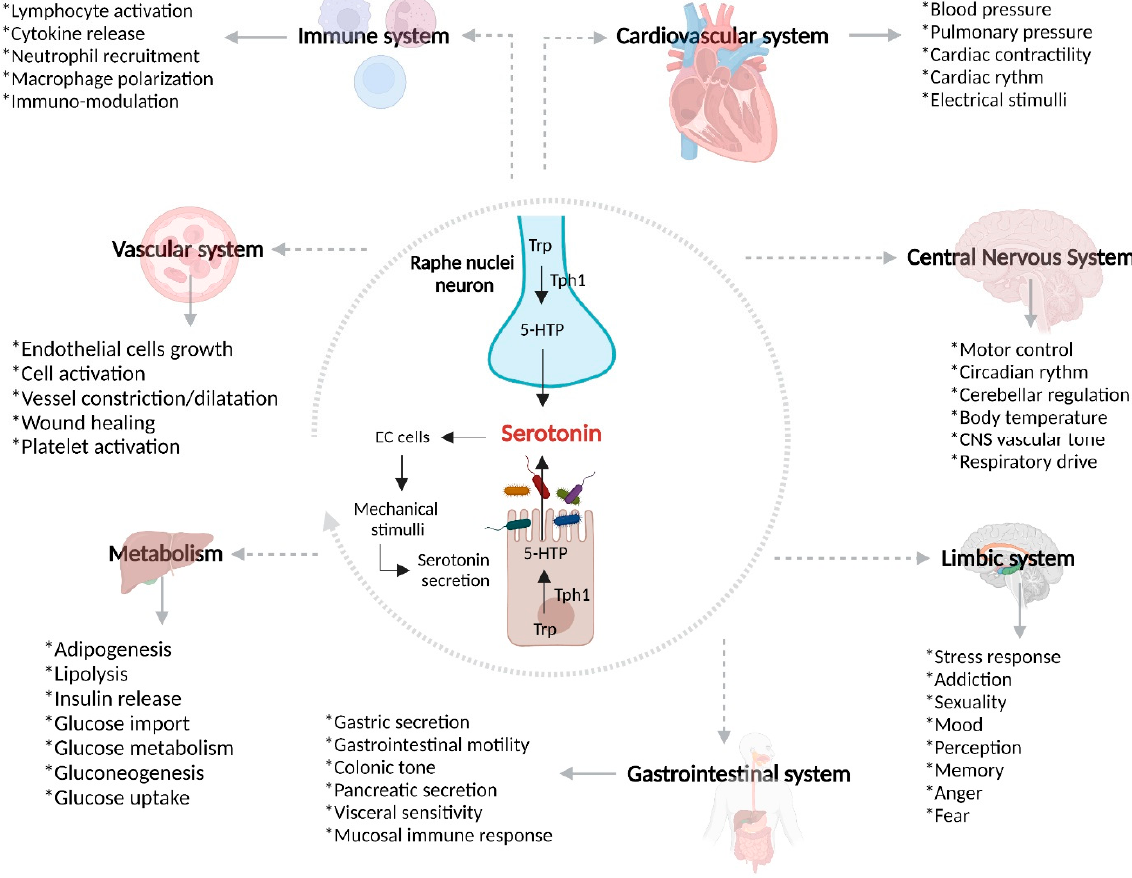
Figure 1. Serotonin biological properties. Serotonin is a well-known monoamine with a wide range of biological properties; it has been seen to be involved in vascular tone and responsible for cardiovascular functions. In the Central Nervous System, it is related to both neurological and cognitive functions such as mood, motor control and others. Interestingly, serotonin is involved in most gastrointestinal functions, from motor to immune properties. Trp, Tryptophan; Tph1, Tryptophan hydroxylase; 5-HTP, 5-hidroxytryptophan; EC, Enterochromaffin cells.